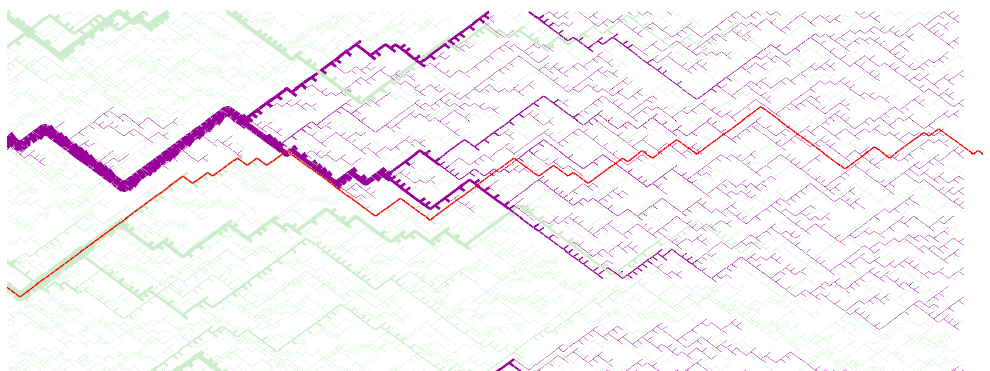
Figure 4. The river network drawn by this stochastic model. In the background, all paths of flowing water from at each site into sinks have been drawn in green. The links sharing a single largest sink are depicted as purple lines. The red line is a sample of the entire path of water flow starting from an initial